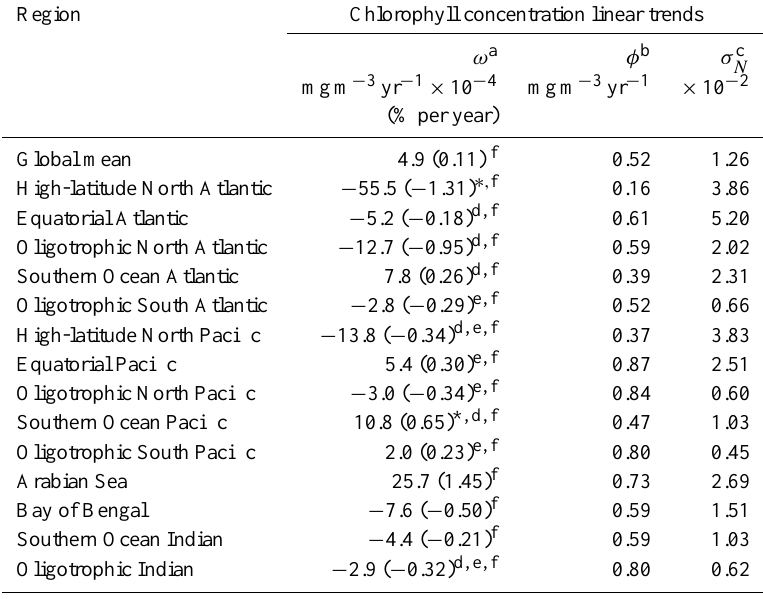
a Linear trend as expressed in Eq. (1). The trends are computed using monthly data, but expressed yearly to be consistent with the trends computed using the models that are presented in Table 2. ∗ The trend is significantly different from zero, 5% significance level. b First-order autocorrelation of the noise estimated as presented in Eq. (2). c Standard deviation of the noise as presented in Eq. (3). d Normality hypothesis rejected, Anderson–Darling normality test, 5% significance